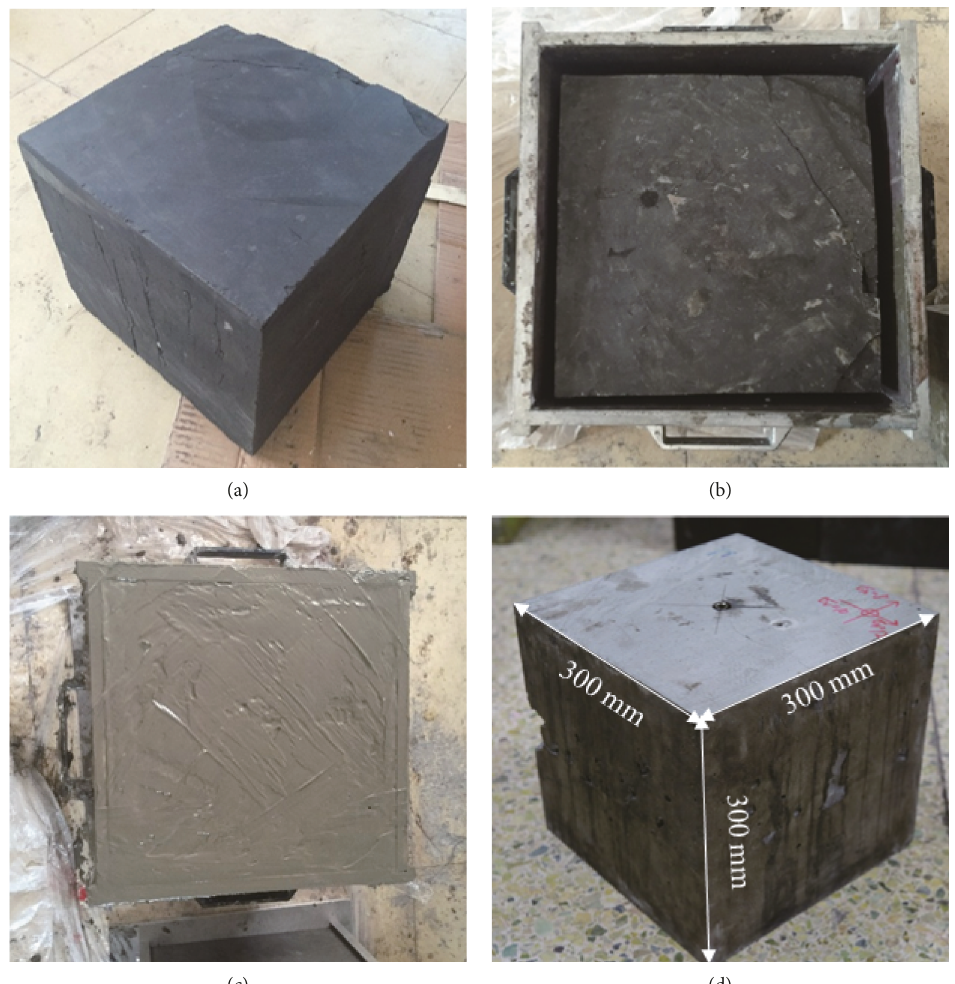
Figure 3: Preparation of standard specimen: (a) cut coal into a cube; (b) load coal sample into the mould; (c) pour cement; (d) complete standard